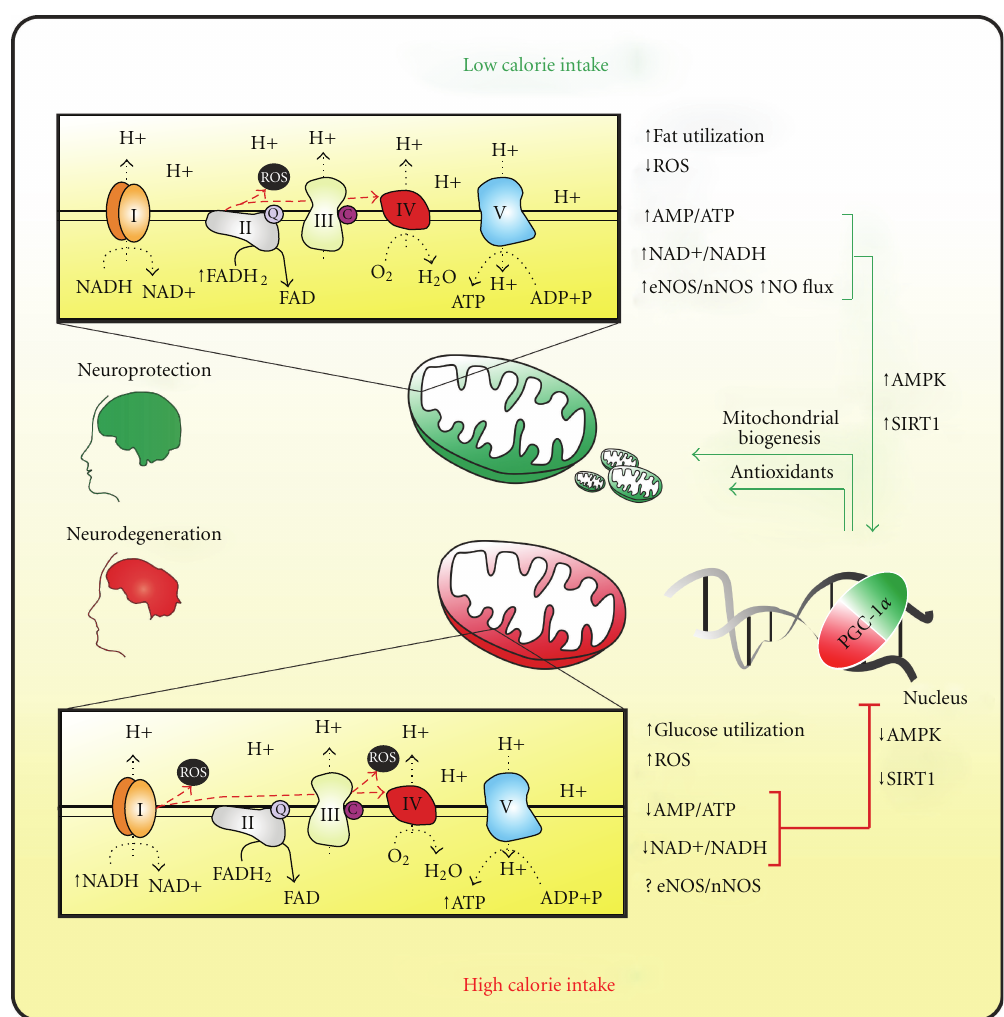
Figure 1: Schematic model of the e ff ect of calorie intake on PGC-1 α -dependent mitochondrial activity and its implication in neuronal